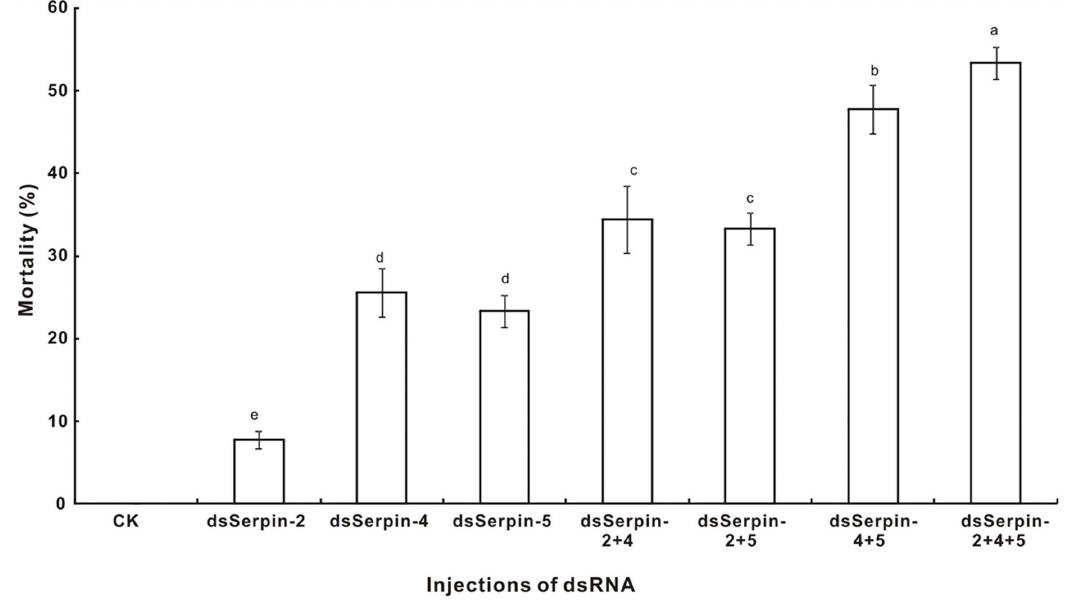
Figure 10. Effect of different serpin knockdown on larval mortality of Plutellaxylostella . Each treatment was injected with 2 m l of a solution containing a total of 5 m g dsRNA. Percentage mortality 24 h after RNAi was calculated. Each value was shown as values 6 S.E.M of three independent experiments. Significant differences were indicated with different letters at P , 0.05.